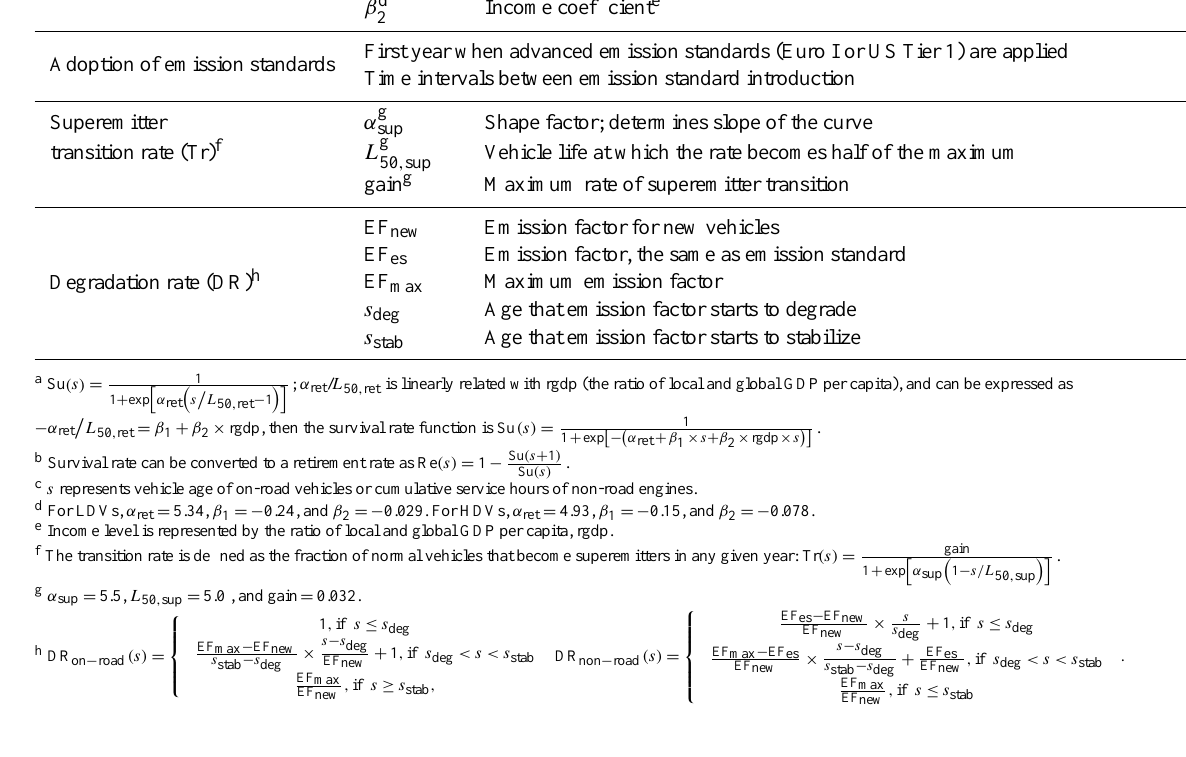
Adoption of emission standards